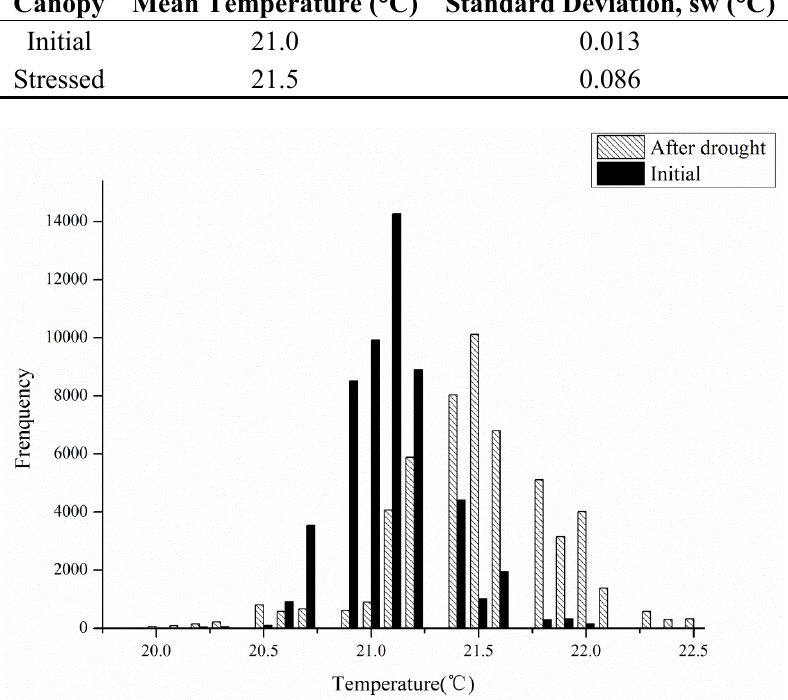
Figure 5. Leaf temperature distributions before and after water deficit treatment.